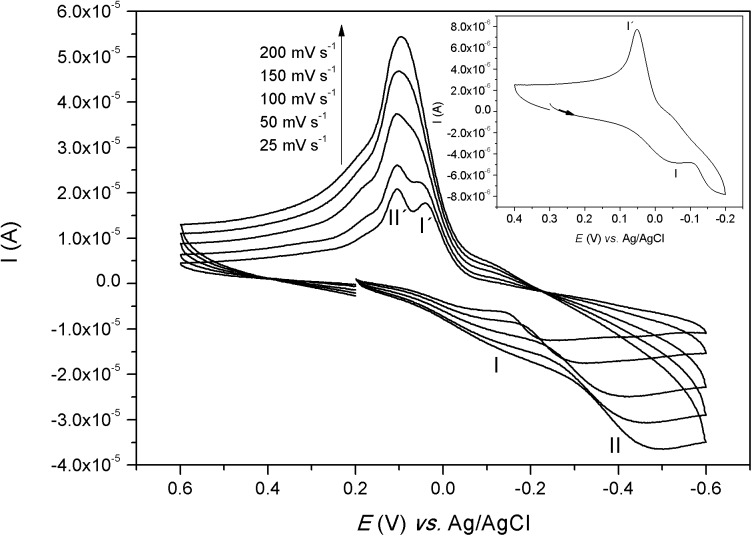
Cyclic voltammogram of [Cu(HL)](ClO4)2, in water.K3[Fe(CN)6] (E
1/2 = 0,254 V versus Ag/AgCl; ΔE = 347 mV) was used as internal standard. Inlet: voltammograms at 25 mV s-1.